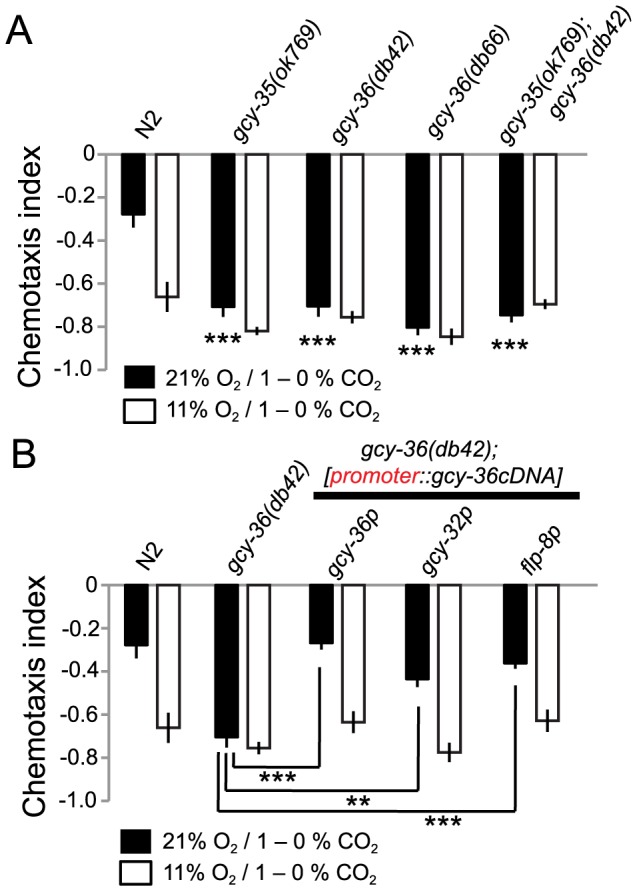
Disrupting gcy-35 or gcy-36 confers strong CO2 avoidance regardless of ambient O2.A. gcy-35 or gcy-36 mutants strongly avoid the high CO2 half of a 1–0% CO2 gradient regardless of ambient O2. Statistics refer to comparisons to N2 at 21% O2. ***, p<0.001, Anova, Bonferroni corrected p-value. None of the strains apart from N2 show significant differences between assays carried out at 21% and 11% O2 (Student's t-test). B. The CO2-avoidance phenotype of gcy-36 mutants can be rescued by expressing gcy-36 cDNA in AQR, PQR and URX, using gcy-32 or gcy-36 promoters, or in URX alone, using the flp-8 promoter. **, p<0.01, ***, p<0.001, Anova, Bonferroni corrected p-value.